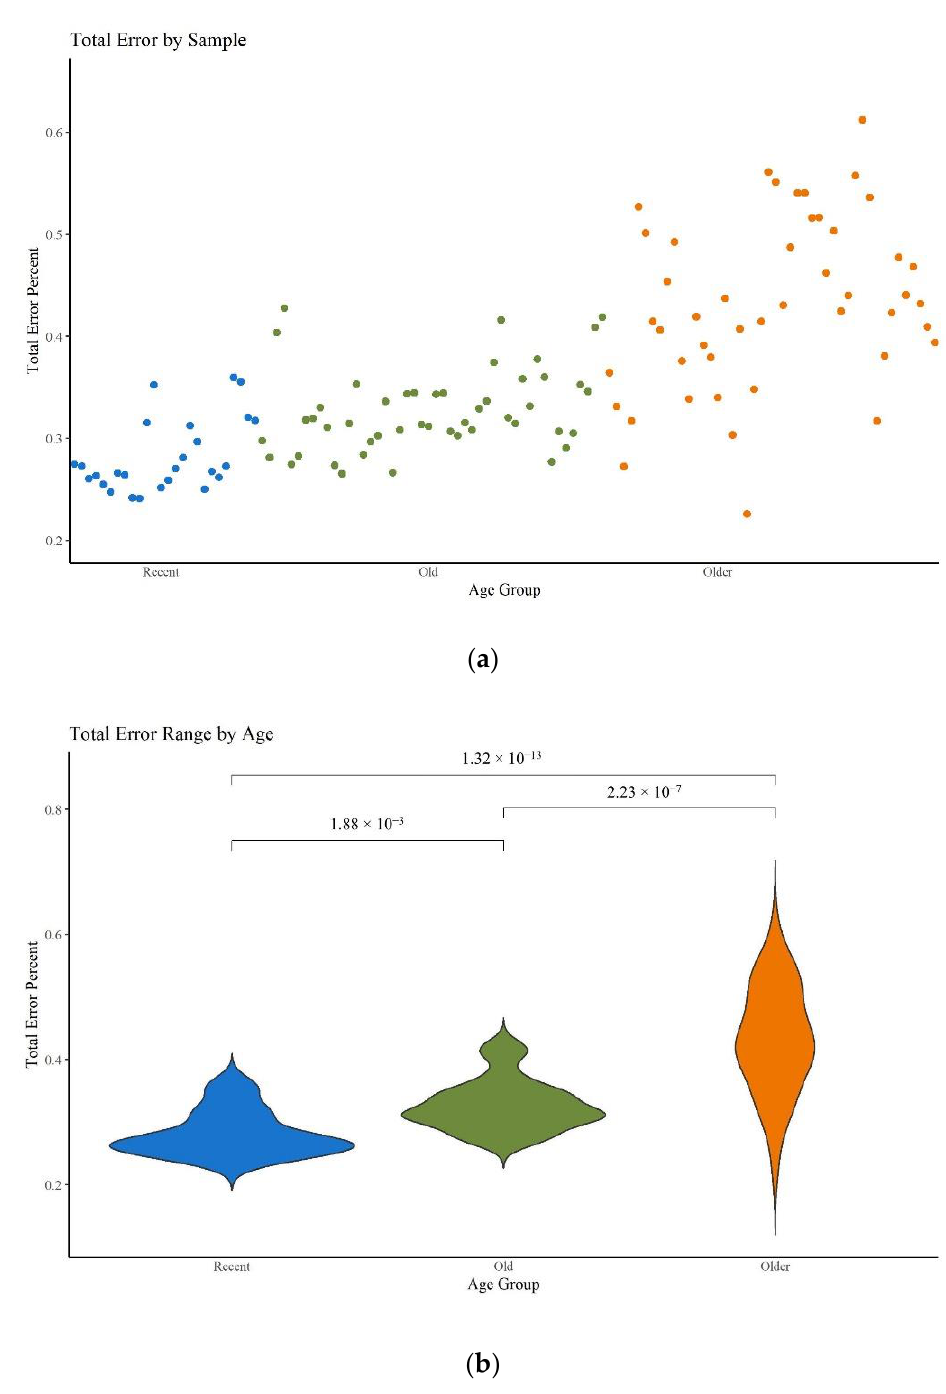
Figure 10. ( a ) Scatter plot of the total error for each sample. ( b ) Violin plot of the total error per age group. Brackets show comparisons with significant p -values ( p < 0.05).